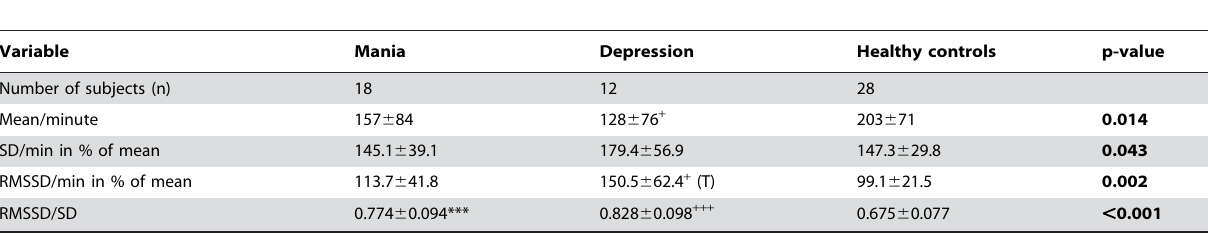
Table 3. Results from the 24-hour recording of motor